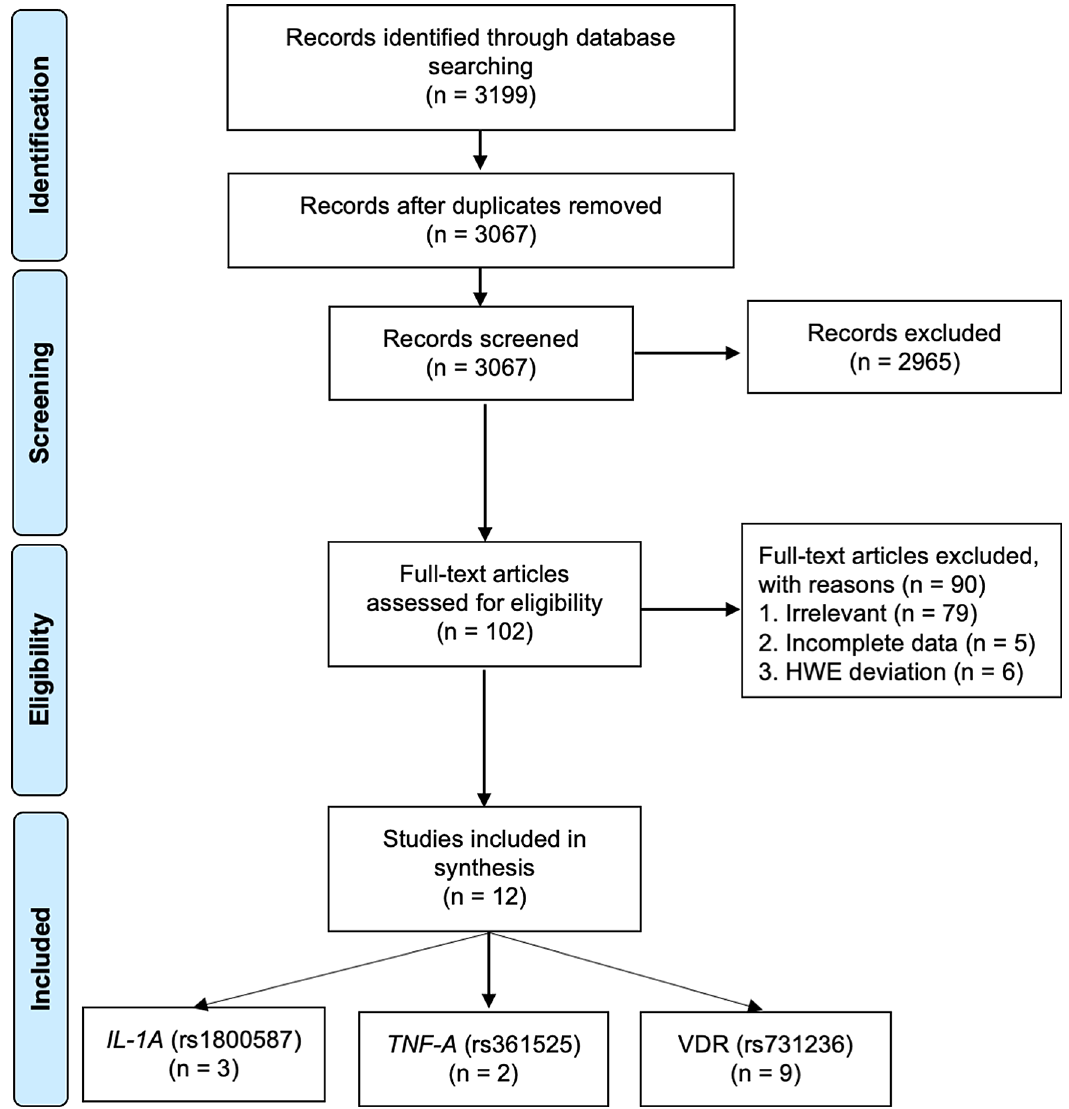
Figure 1. Flowchart of the result of literature searches according to the preferred reporting items of systematic reviews and meta-analyses